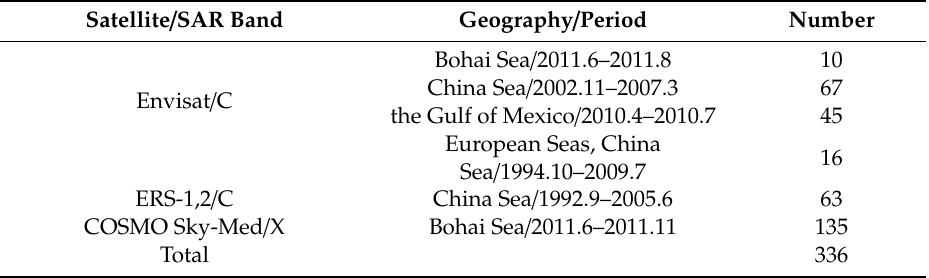
Table 1. Information of original synthetic aperture radar (SAR) image